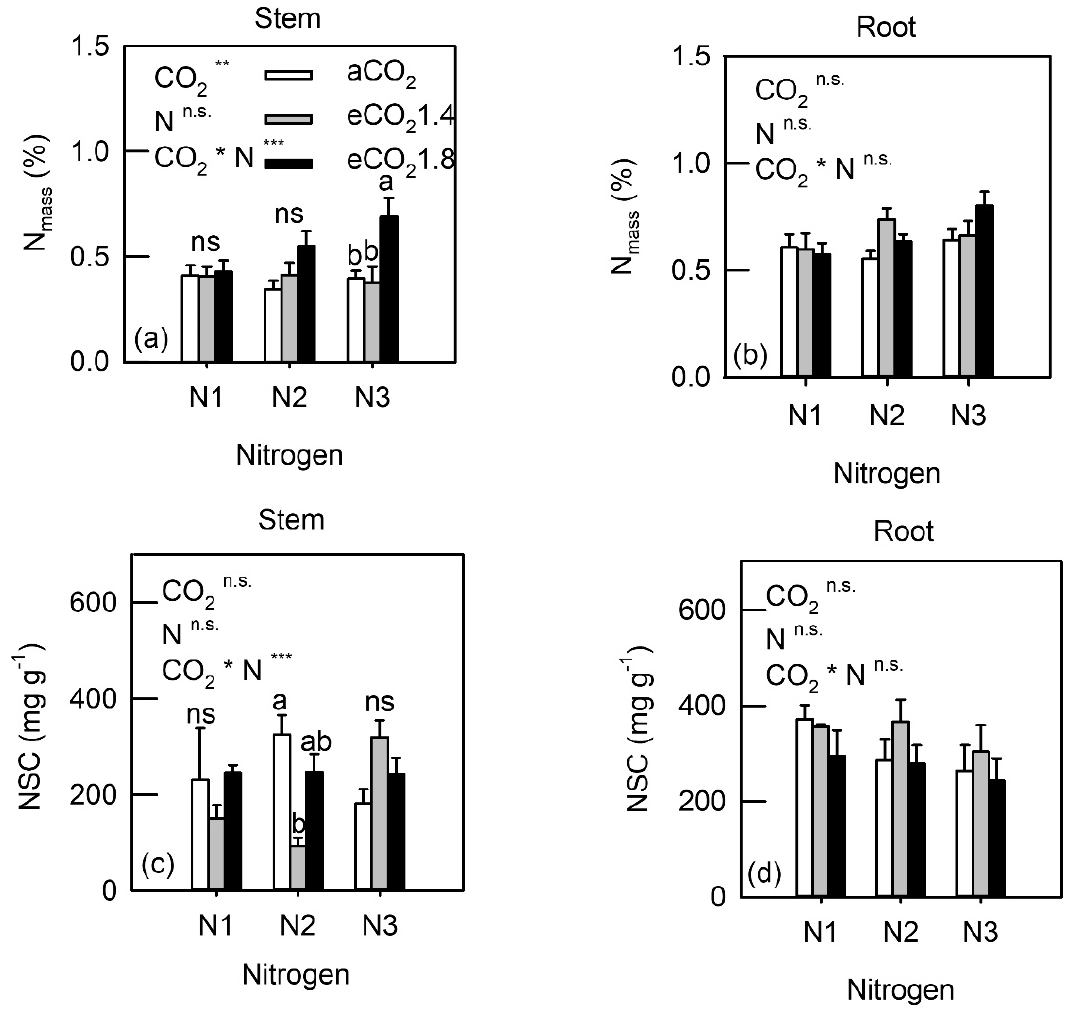
Figure 3. Average of the nitrogen per unit mass (N mass ) from ( a ) stem and ( b ) root and nonstructural carbohydrates per unit mass (NSC) from ( c ) stem and ( d ) root measured in Fraxinus rhynchophylla grown at three different CO 2 chambers (ambient: aCO 2 ; ambient × 1.4: eCO 2 1.4; ambient × 1.8,: eCO 2 1.8) and three different N treatments (N1: unfertilized, N2: N1 + 5.6 gN m − 2 yr − 1 and N3: N1 + 11.2 gN m − 2 yr − 1 ). Results are presented as mean + SE and summary of a two-way ANOVA. In the summary of the two-way ANOVA, CO 2 represents the CO 2 treatment and N represents the nitrogen treatment. The X axis represents N fertilization and CO 2 treatments: aCO 2 (white bar), eCO 2 1.4 (grey bar) and eCO 2 1.8 (black bar). The significance of the primary effects and their interactions are shown with the abbreviations. n.s, non-significant; *, p < 0.05; **, p < 0.01; ***, p < 0.001 (two-way ANOVA, CO 2 × N). Different lowercase letters indicate significant differences among CO 2 treatment in each N treatments and capital letters indicate significant differences among N treatment (Tukey’s test, p < 0.05).